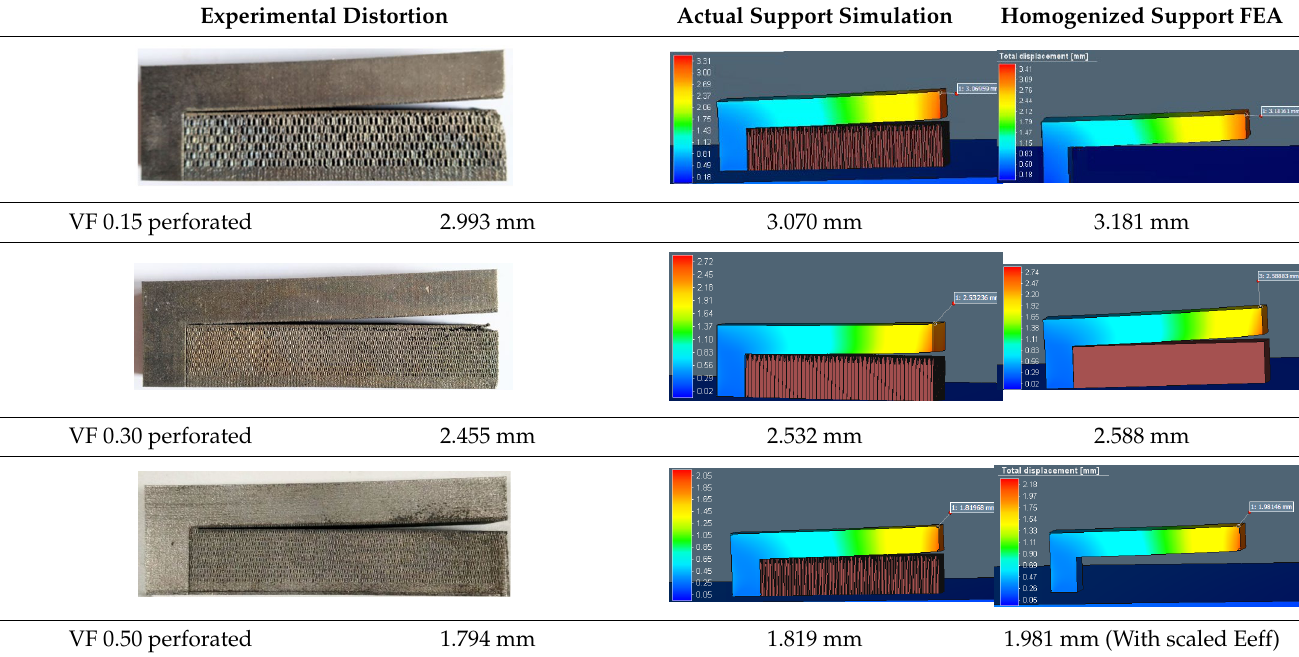
Table 6. VF of homogenized model scaled using the Gibson–Ashby model for perforated block support.